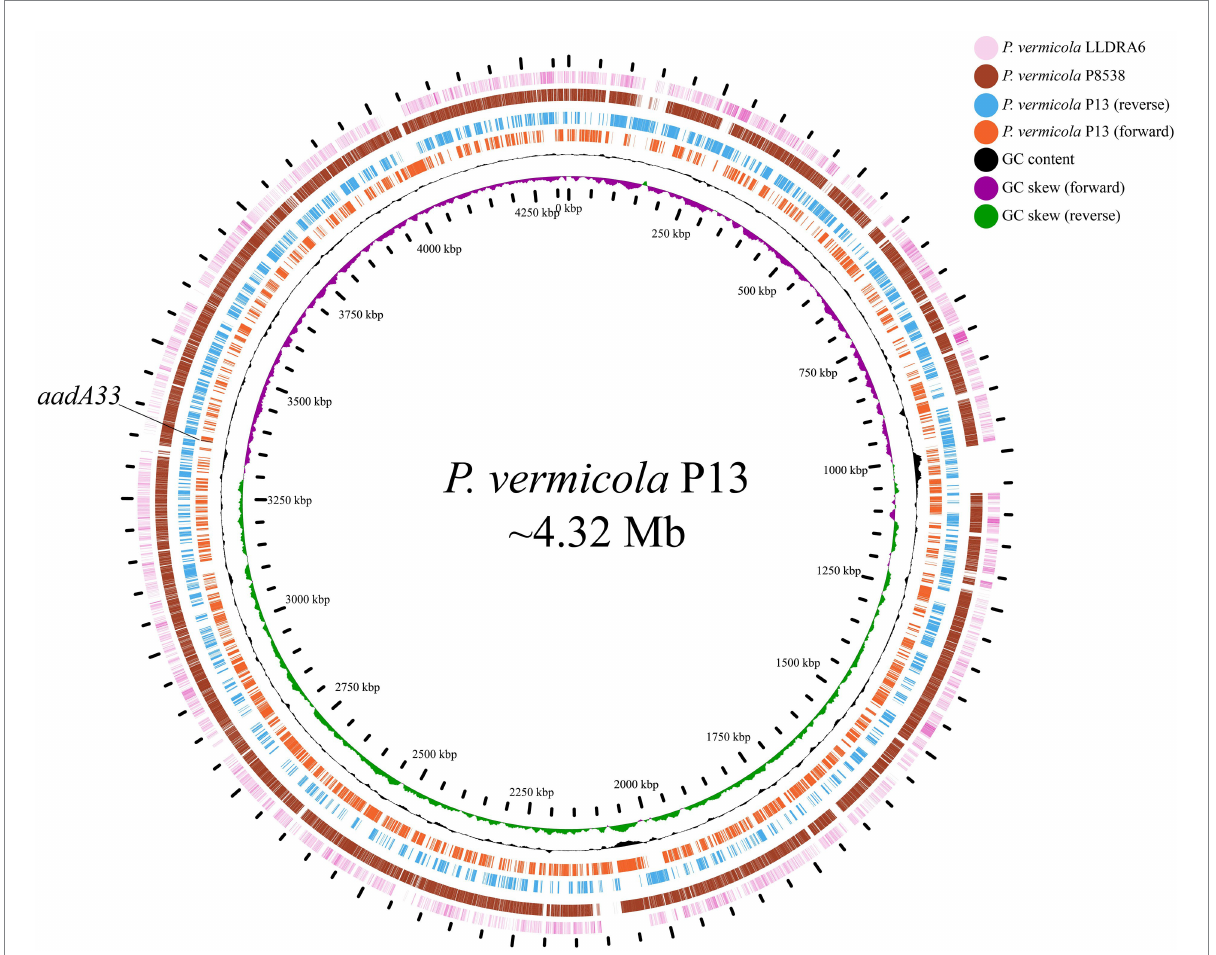
FIGURE 1 Genome maps of Providencia vermicola P13 and its close relatives. Circles from inside to outside represent GC skew, GC content, genes encoded in the forward and the reverse strands of the chromosome of P. vermicola P13, the P. vermicola P8538 chromosome (CP048796.1), and the P. vermicola LLDRA6 chromosome (CP067099.1), respectively. Regions with <80% nucleotide identities with that of the P. vermicola P13 chromosome are left